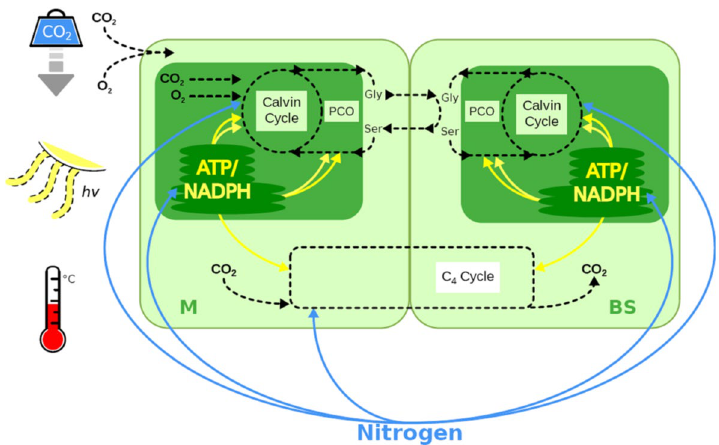
Figure 1. An overview of the nitrogen-dependent light- and enzyme-limited model. CO 2 entering the mesophyll cell (M) can be fixed by Rubisco (C 3 and intermediates) or PEPC (C 4 and intermediates); The C 4 cycle then shuttles CO 2 fixed by PEPC to the bundle sheath cell (BS) and releases it, allowing it to be re-fixed by Rubisco. The fixation of O 2 by Rubisco leads to photorespiration (PCO). Blue arrows indicate the nitrogen allocation and yellow arrows represent the energy allocation considered in the